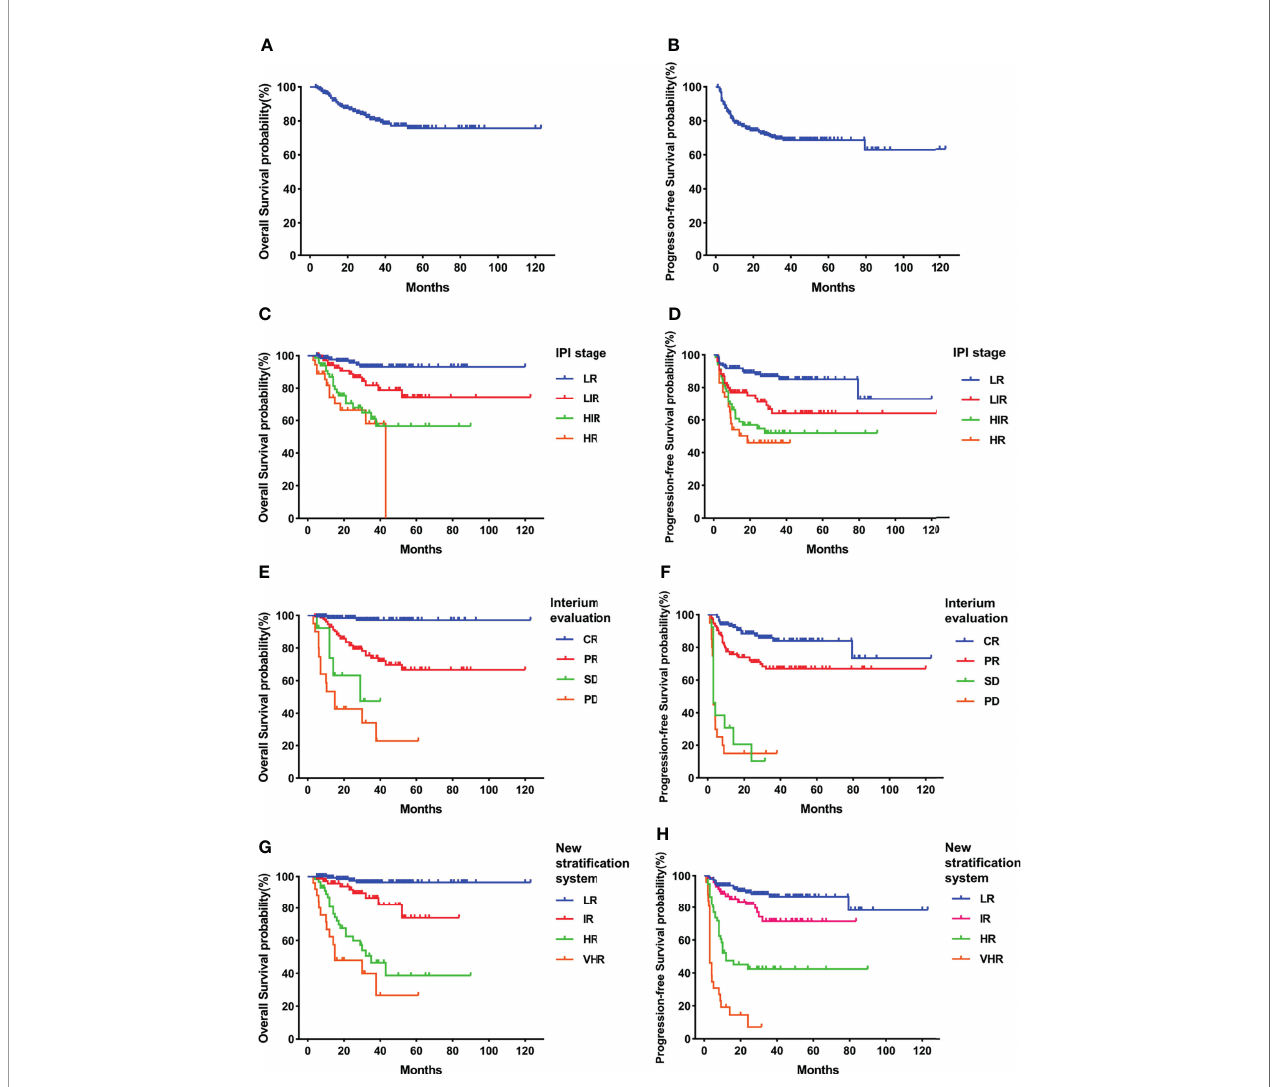
FIGURE 1 | Survival rates of the total cohort. (A) Overall survival (OS). (B) Progressive-free survival (PFS). (C) OS according to International Prognostic Index (IPI) and interim evaluation. (D) PFS according to IPI and interim evaluation. (E) OS when strati fi ed with interim evaluation. (F) PFS when strati fi ed with interim evaluation. (G) OS according to the new risk strati fi cation system by combination of interim evaluation and IPI. (H) PFS according to the new risk strati fi cation system by combination of interim evaluation and